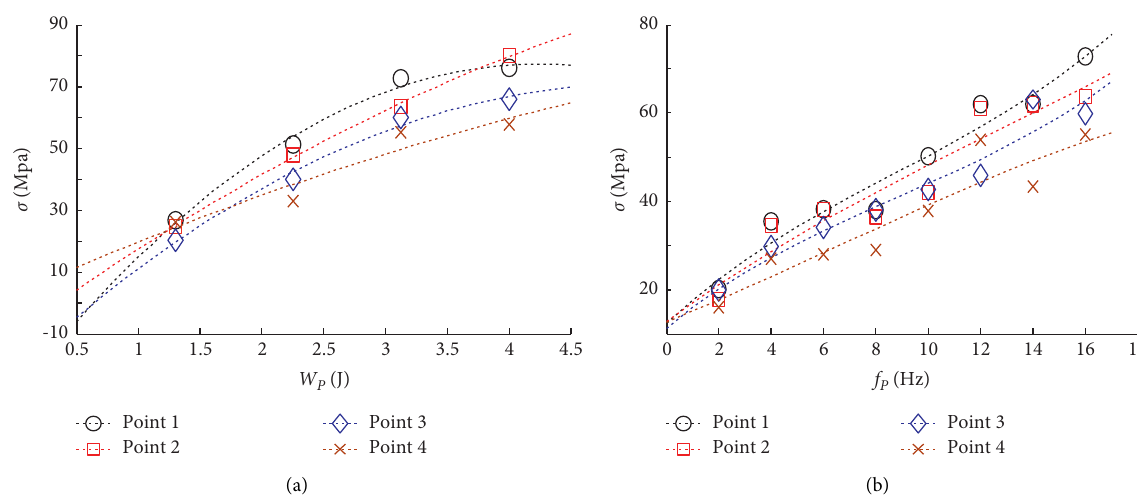
Figure 13: The impact stress at each measuring point under different input parameters. (a) Curves of impact stress vs. impact energy. (b) Curves of impact stress vs. percussive frequency.